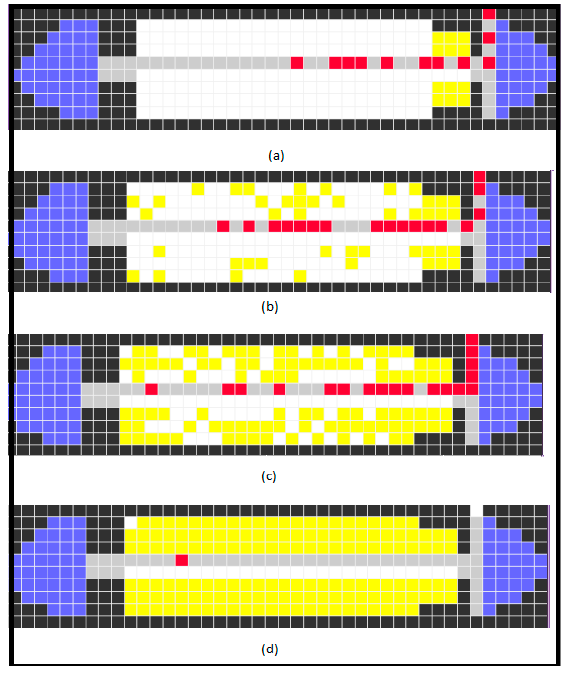
Figure 24. Random strategy.